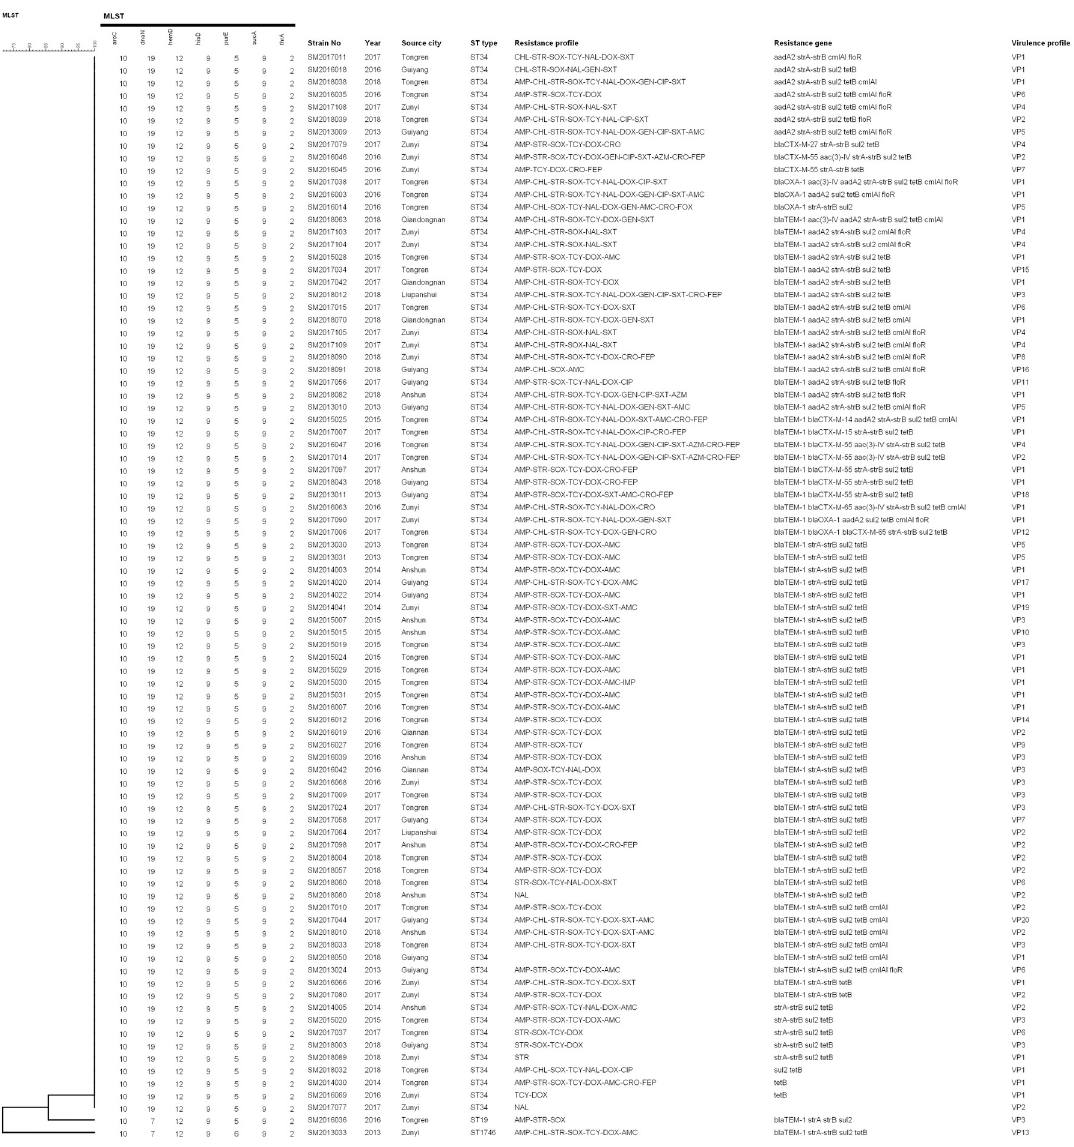
Fig 2. MLST clustering tree of the 87 Salmonella 4,[5],12:i:- isolates in Guizhou from 2013 to 2018 with the antimicrobial resistance profile, antimicrobial resistance genes, and virulence gene profile.